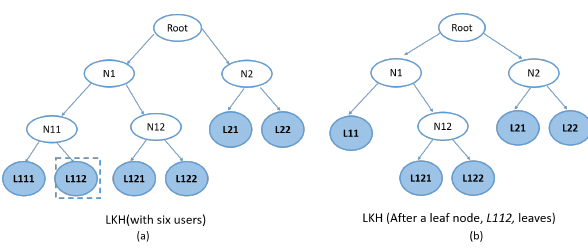
Figure 4. The figure shows the LKH tree before and after node L112 leaves the